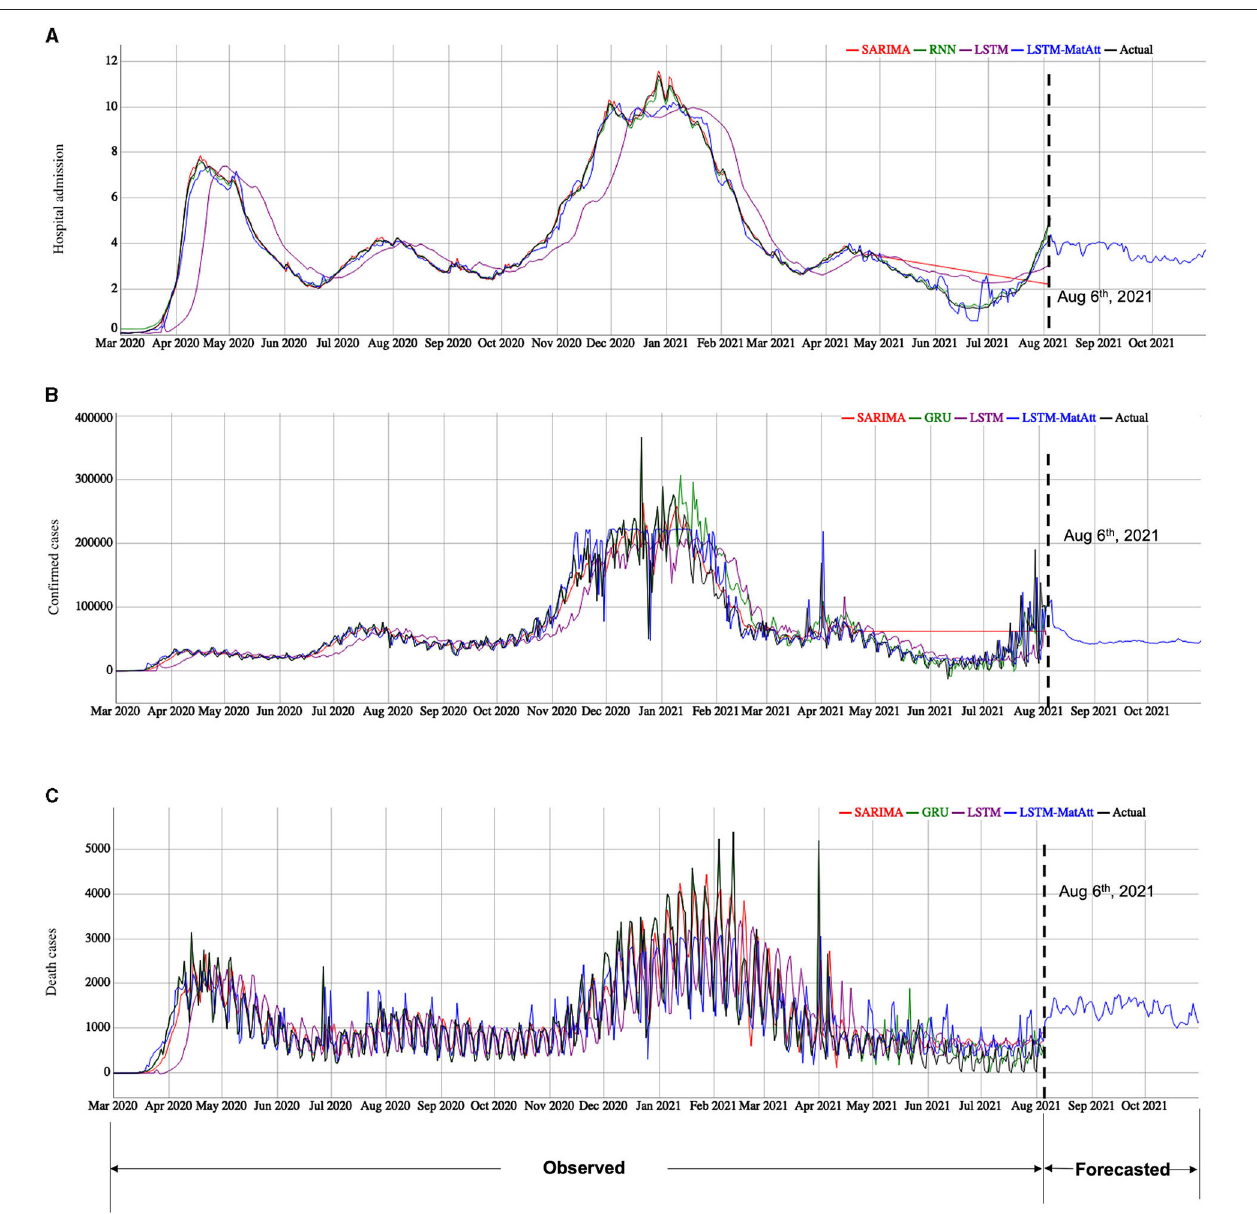
FIGURE 4 | The model fitting and forecasting results of the three COVID-19 indicators by the selected models. (A) is the results for hospital admission, (B) is the results for confirmed cases, and (C) is the results for death cases . We showed the model fitting results based on the observed data from March 1, 2020 to August 5, 2021. The selected models are based on the performance shown in Table 2 for the categories of traditional statistical models, RNN-based models, and the family of the LSTM models, including our proposed LSTM-based models. The model forecasting results are based on the best model among the proposed and the compared models for each